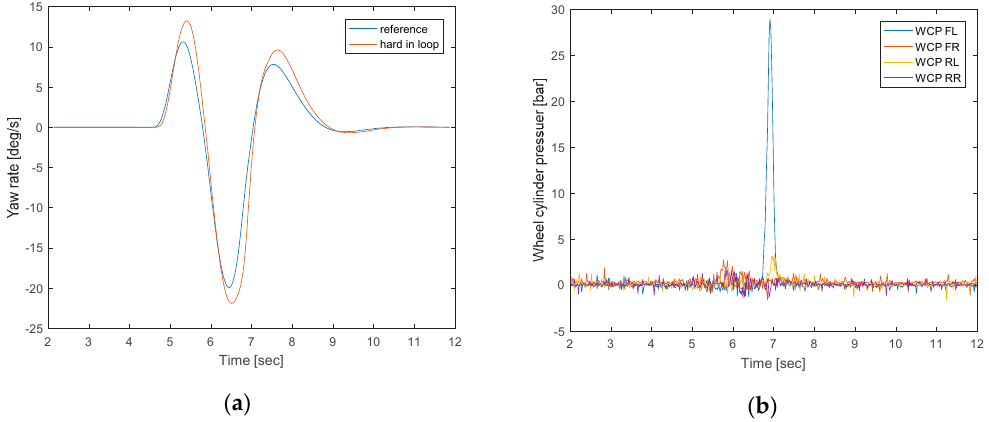
Figure 17. Test results based on the tire force observation controller at 𝑢 = 80 km/h and 𝜇 = 0.8. ( a ) is a comparison of the nominal and actual values of the yaw rate, and ( b ) is the wheel cylinder pressure value collected from the wheel cylinder pressure sensor.